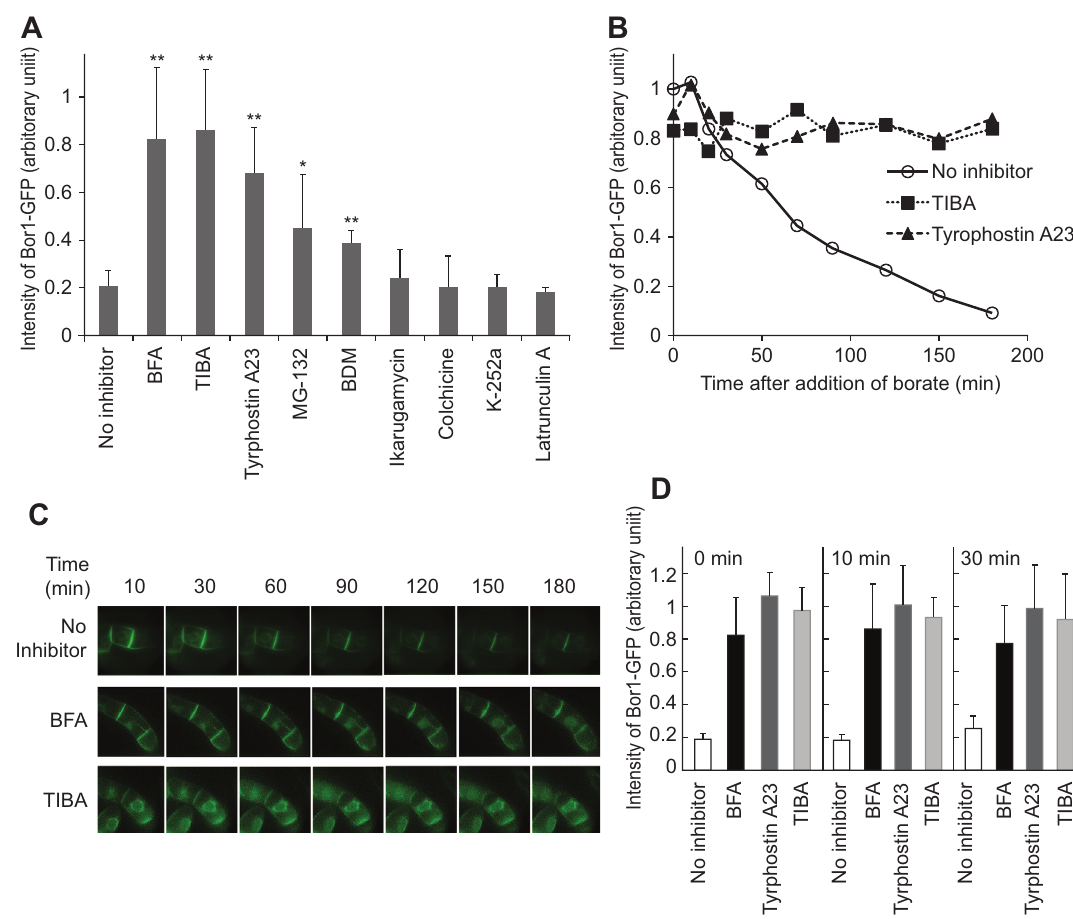
Figure 7. Inhibitors that prevent borate-dependent degradation. A . Cells incubated with or without inhibitors for 30 min were further incubated in medium containing 5 mM of borate for two hours in the presence of the same inhibitors. The relative intensity of BOR1-GFP fluorescence was quantified as described in the Figure 3 legend. The final concentration of inhibitors in the culture and the number of replicates were; brefeldin A (BFA), 25 μM, n=8; 2,3,5-triiodobenzoic acid (TIBA), 50 μM, n=5; tyrphostin n=5; Tyrphostin A23, 100 μM, n=5; MG-132, 400 μM, n=5; 2,3-butanedione monoxime (BDM), 40 mM, n=3; K-252a, 4 μM, n=3; Ikarugamycin, 20 μM, n=3; Latrunculin A, 100 μM, n=3; colchicin, 200 μM, n=3. Error bars, SD. ** and * represent the significant difference relative to no inhibitor (p<0.01 and <0.05